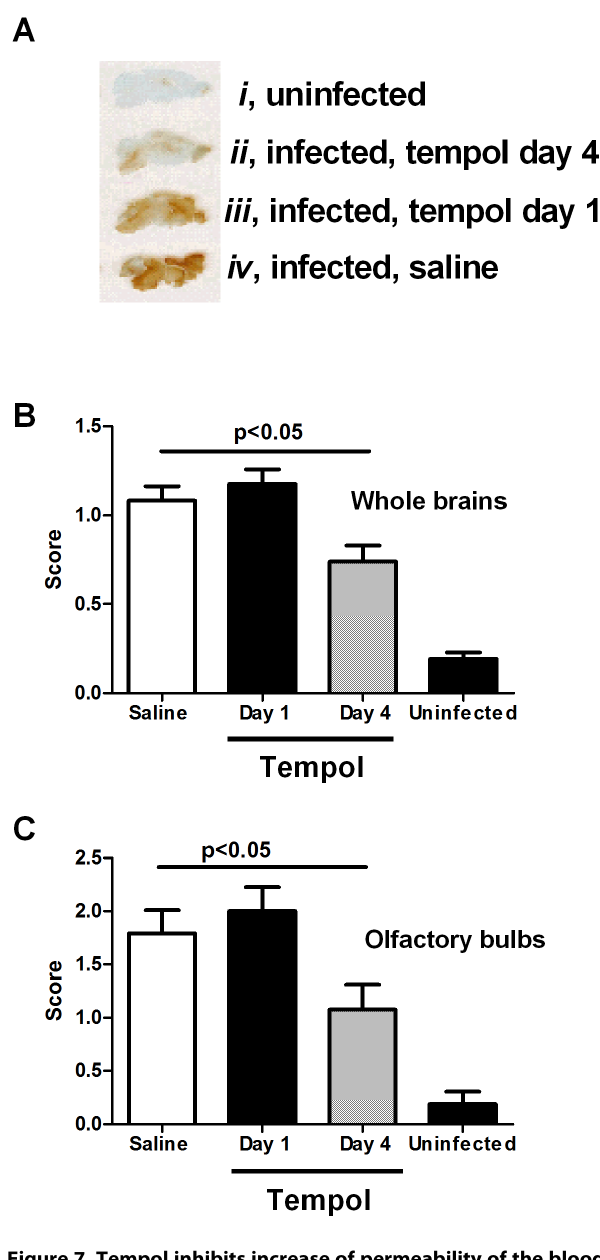
Figure 7. Tempol inhibits increase of permeability of the blood brain barrier (BBB). Plasmodium berghei Anka parasitized red blood cells (10 6 ) were injected into mice intraperitoneally (i.p.) Tempol (100 m L; 20 mg/kg), was started at day 1 or day 4 post infection (p.i.). At day 6 p.i., all animals were euthanized and the brain immediately dissected and fixed. Permeability of the BBB was detected as extravasation of IgG as described in Materials and Methods. A, A typical experiment is shown: i, uninfected mice; ii, infected and treated with Tempol (day 4); iii, infected and treated with Tempol (day 1); and iv, infected, non-treated mice. B, Quantification of inflammation of the whole brain. C, Quantification of inflammation of the olfactory bulbs. Quantification was performed as described in Materials and Methods. Ten mice were analyzed per group. *, P # 0.05 (ANOVA, Tukey post-test).